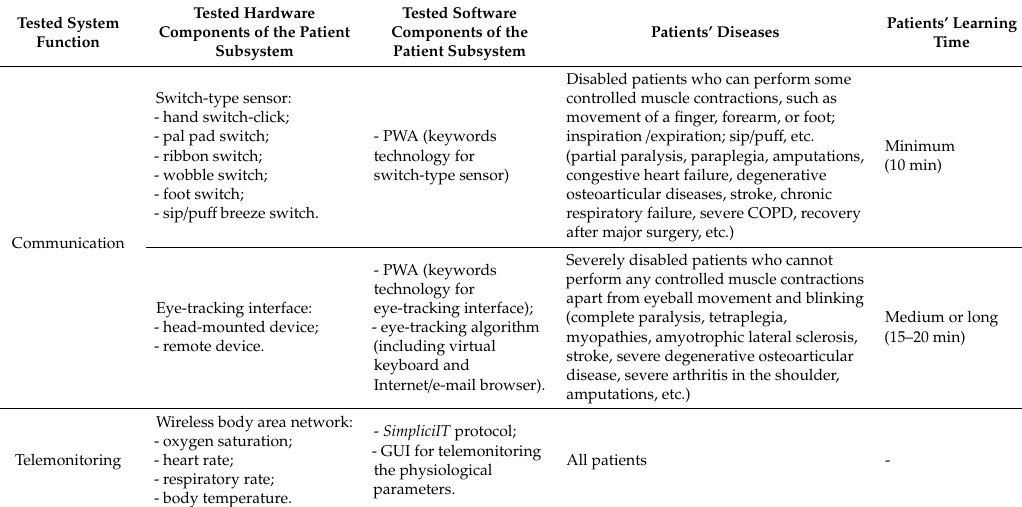
Table 3. Testing plan: tested hardware / software components of Patient Subsystem, patients’ diseases, and learning time depending on system